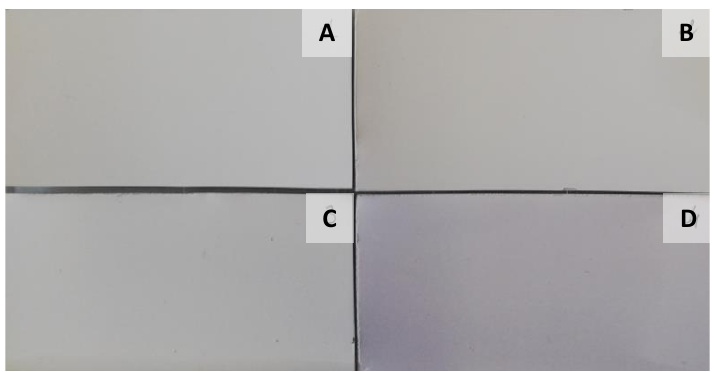
Figure A1. TLC plates sprayed and incubated with: ( A ) TMPD, ( B ) arachidonic acid/TMPD, ( C ) COX-2/TMPD, ( D ) COX-2/arachidonic acid/TMPD.